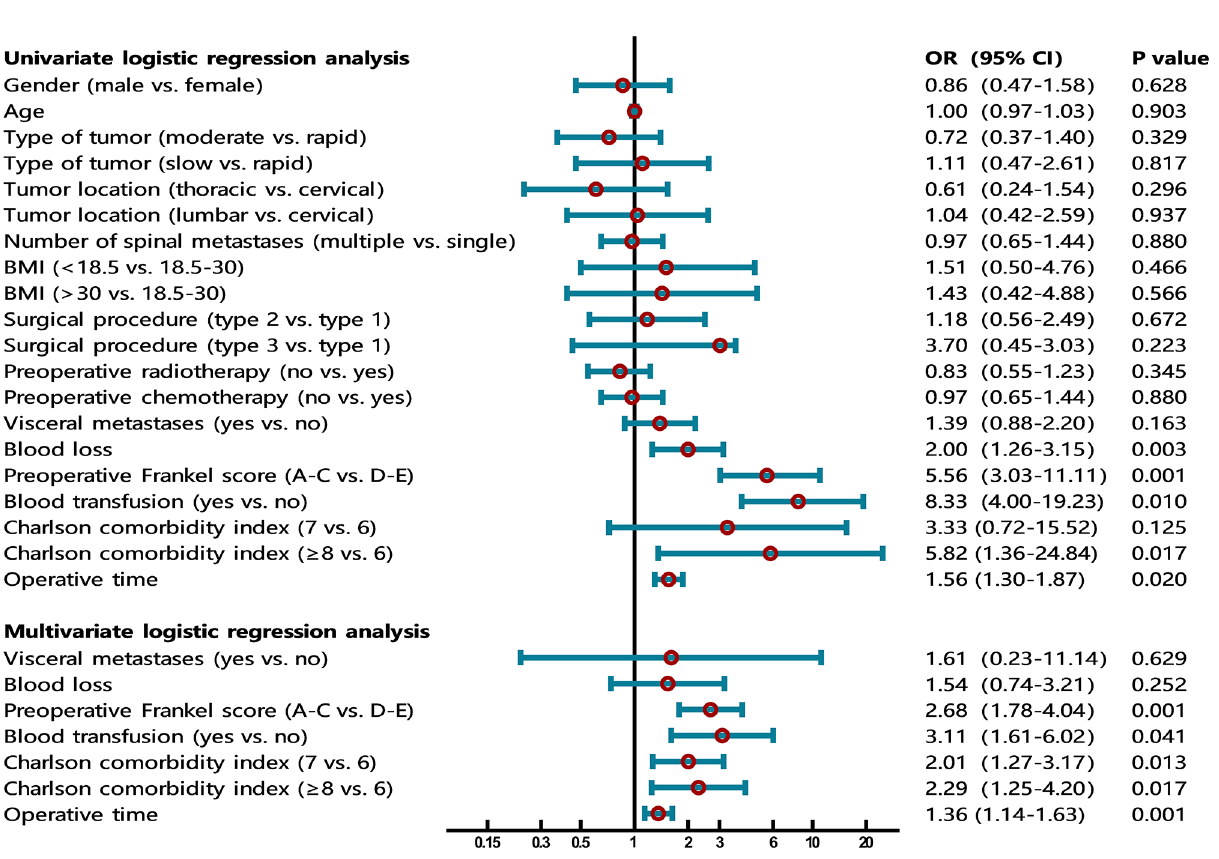
FIGURE 1 | The forest plot shows the results of univariate and multivariate analyses. In the multivariate logistic regression model, four independent risk factors for VTE were further screened out, including preoperative Frankel score (OR=2.68, 95% CI 1.78-4.04, P=0.001), blood transfusion (OR=3.11, 95% CI 1.61-6.02, P=0.041), Charlson comorbidity index (OR=2.01, 95% CI 1.27-3.17, P=0.013; OR=2.29, 95% CI 1.25-4.20, P=0.017), and operative time (OR=1.36, 95% CI 1.14-1.63,